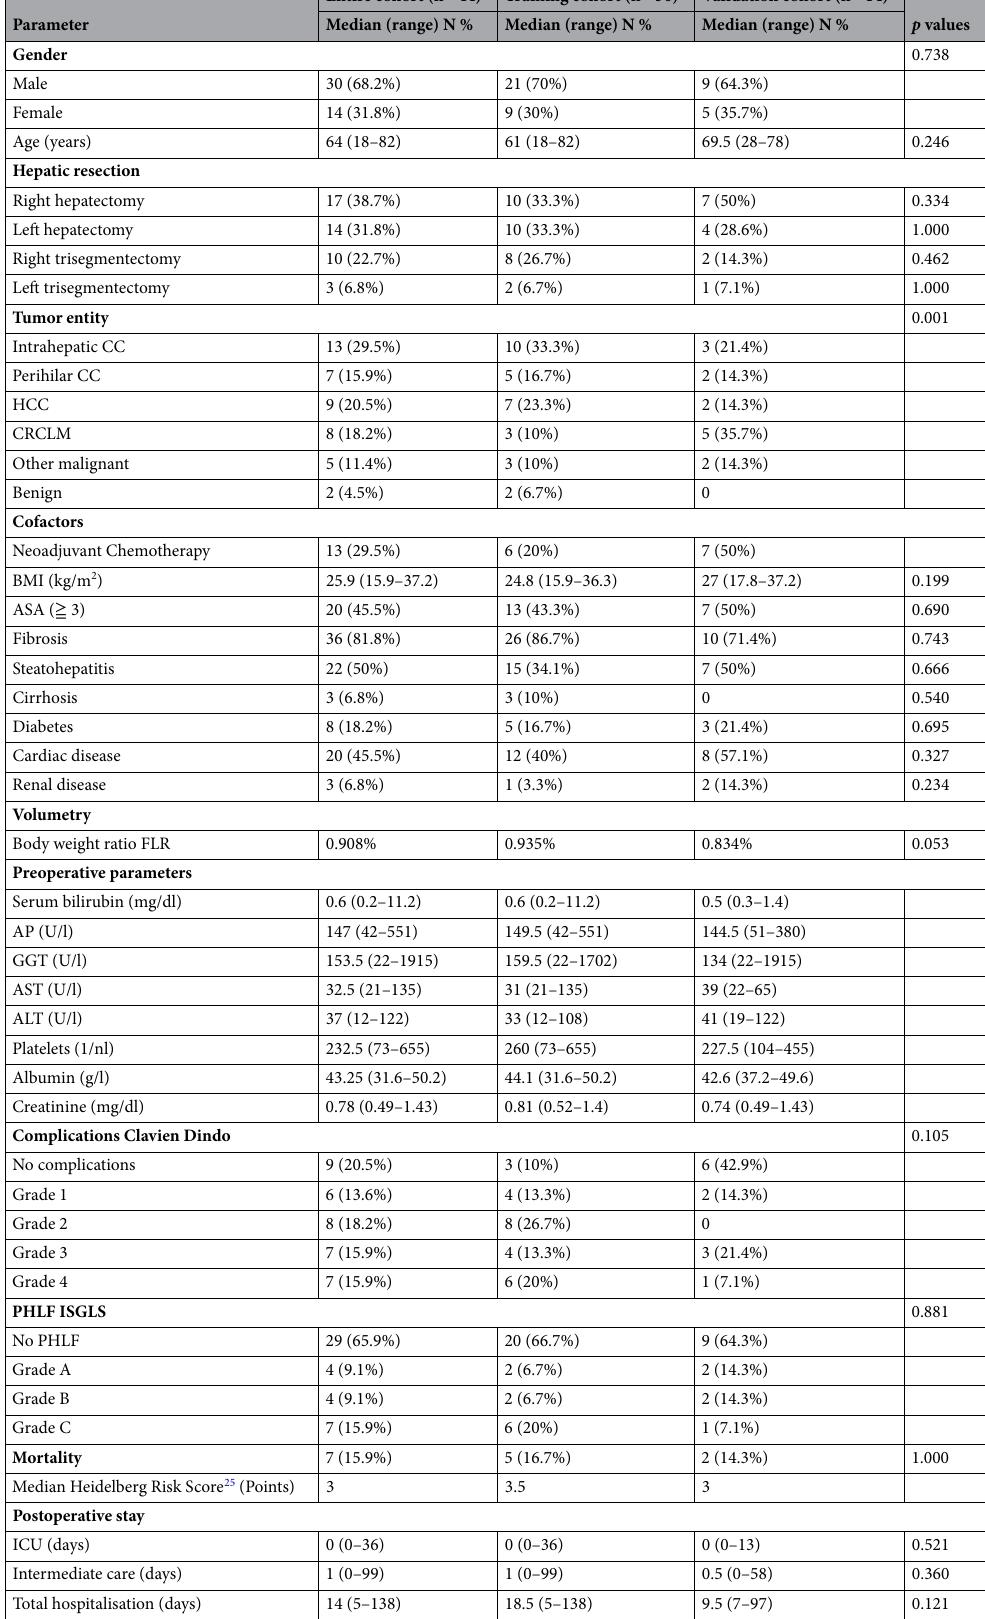
Table 1. Patient characteristics. ICC, Intrahepatic colangiocarcinoma; ECC, extrahepatic colangiocarcinoma; HCC, Hepatocellular carcinoma. Preoperative albumin was missing in 10